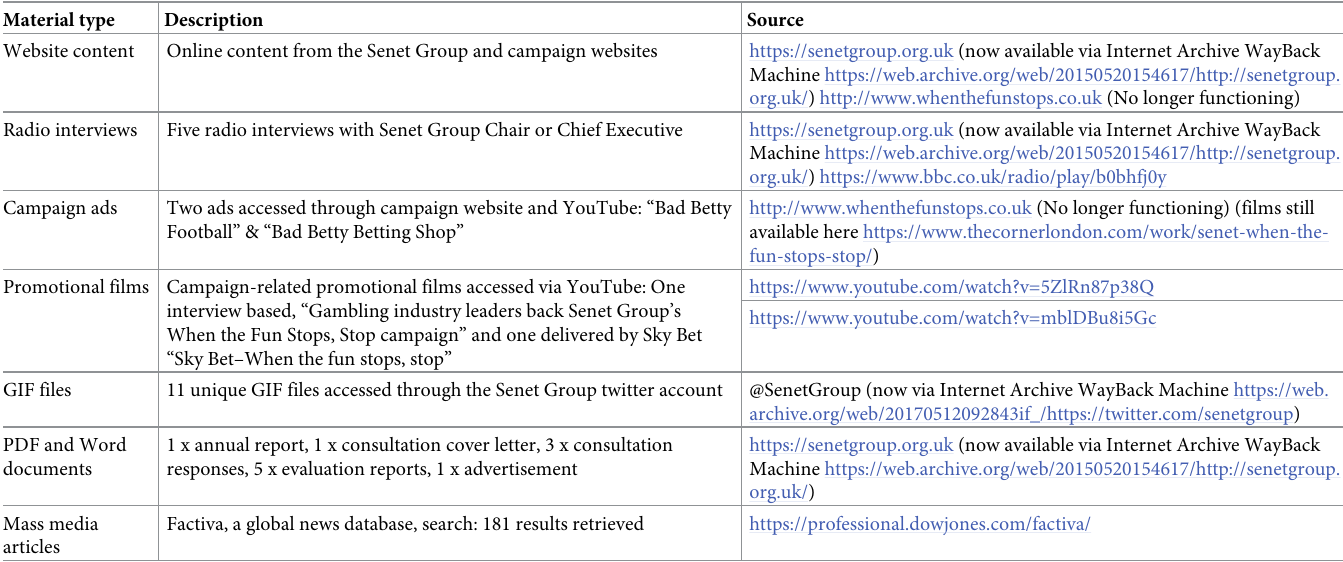
Table 1. Summary of documentary materials collated and included in the analysis.